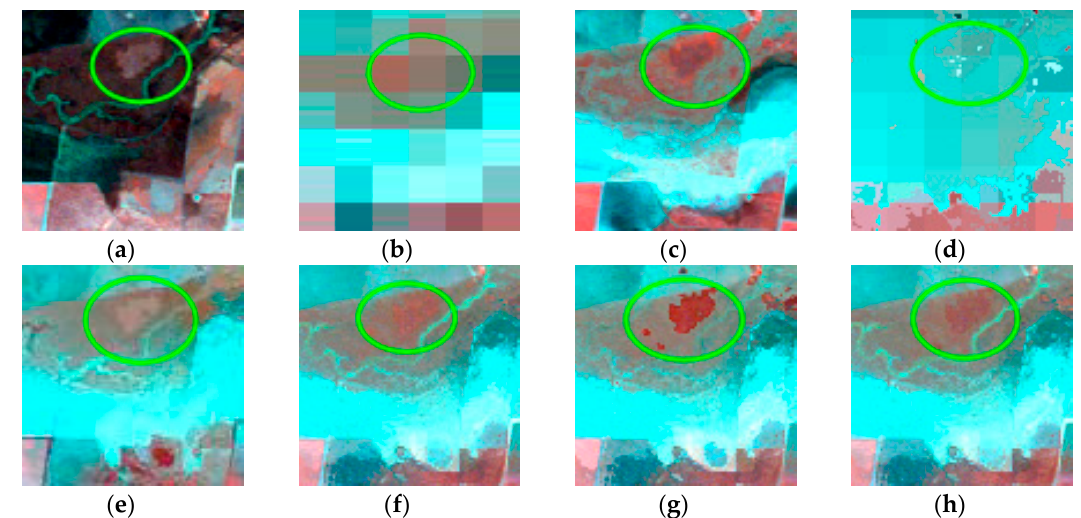
Figure 7. Original Landsat images on November 26, 2004 ( a ), and December 12, 2004 ( b ), and the images predicted by UBDF( c ), FIT-FC( d ), FSDAF( e ), SFSDAF( f ), and adaptive-SFSDAF( g ).